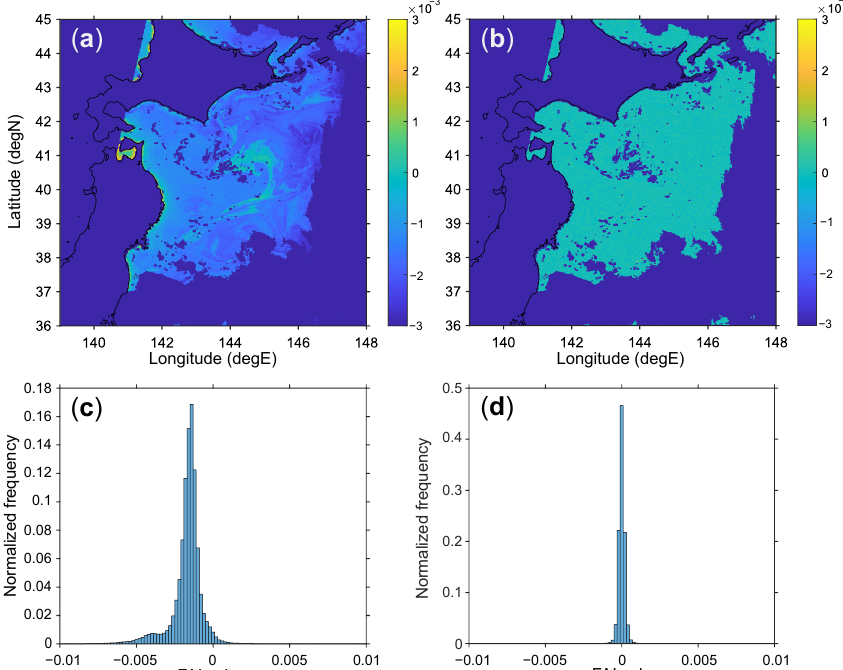
Figure 3. ( a , b ): An example of ( a ) FAI and ( b ) scaled FAI (sFAI) distribution. Subtracting the adjacent ocean’s FAI from the focal FAI yields sFAI, a scaled-down version of FAI. The main text contains a detailed definition and derivation of sFAI. The data collection took place on 7 May 2019. ( c , d ): Normalized frequency of the ( c ) FAI and ( d ) sFAI distributions in the upper